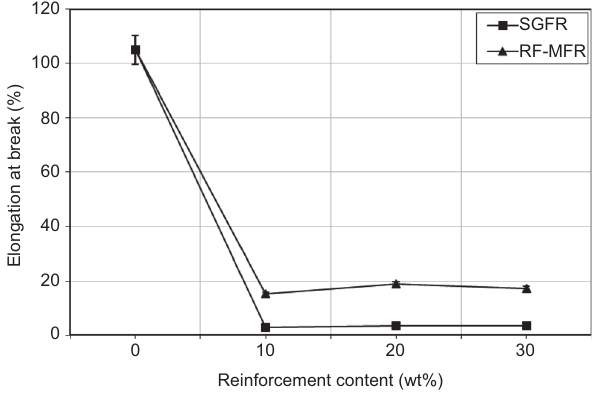
Figure 3 Variation of the elongation at break of PA6 with weight percent of reinforcement